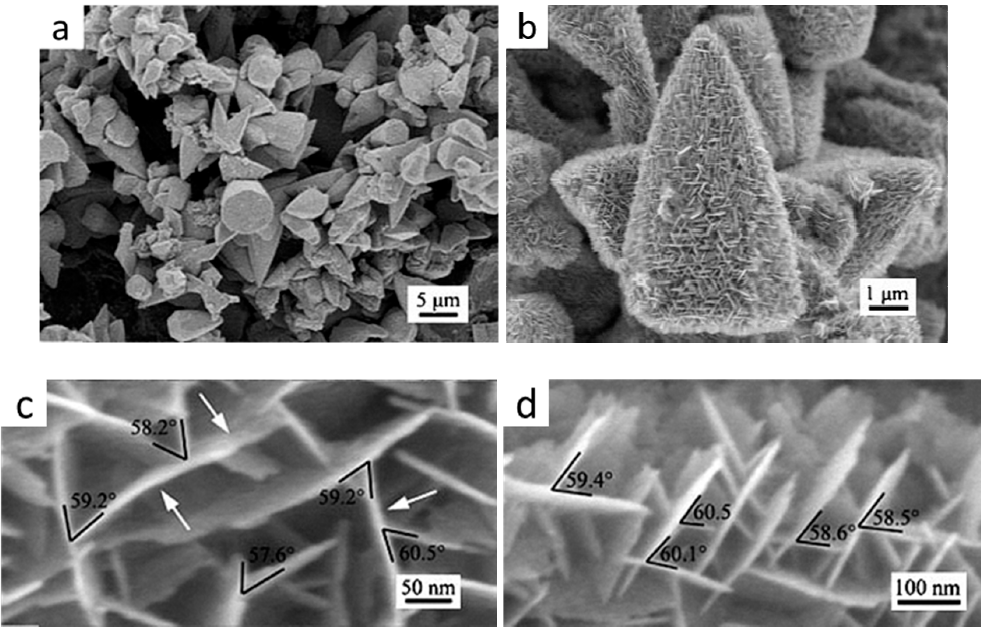
Figure 11. FE-SEM images of the products prepared by the solvothermal reaction. ( a ) A general-view image; ( b ) The local magnification image of ( a ); ( c ) A further enlarged top-view image of ( b ); ( d ) Enlarged local image at the edge of the networks. Reproduced with permission from [216]. Copyright WILEY-CVH,